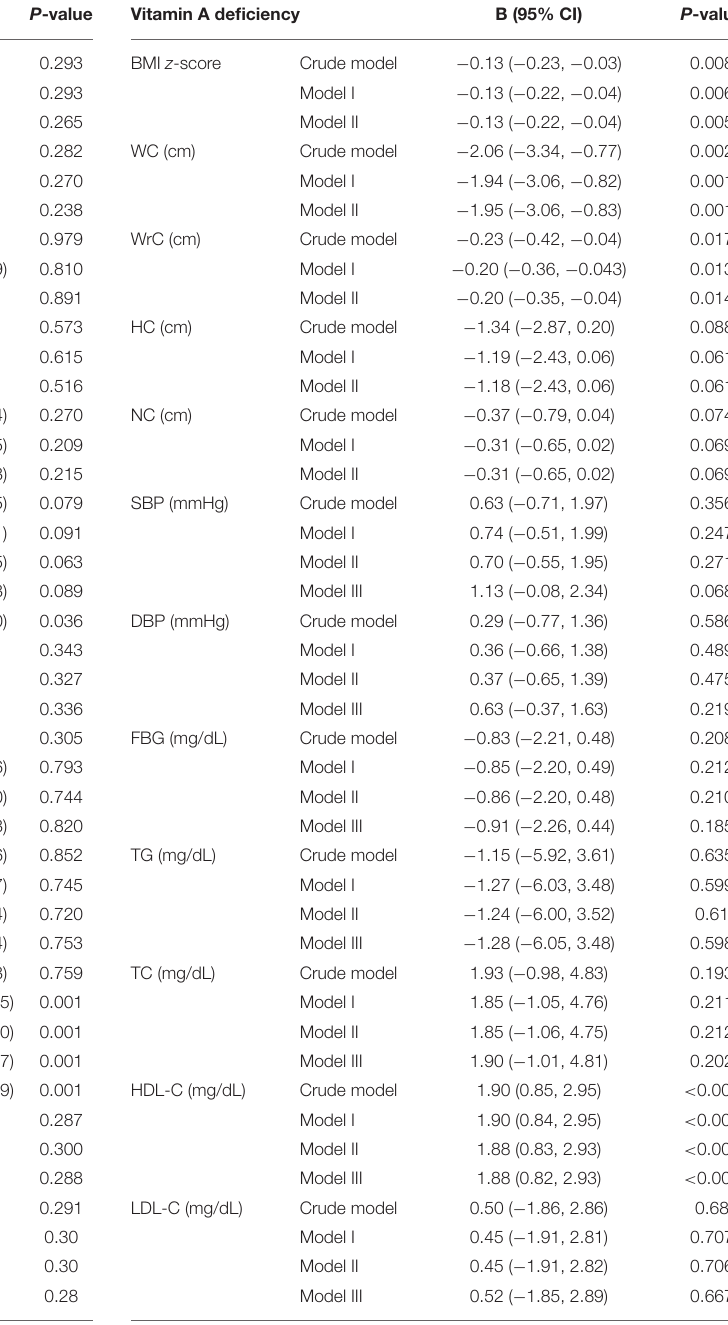
TABLE 4 | Association between vitamin A deficiency with cardiometabolic risk factors in linear regression